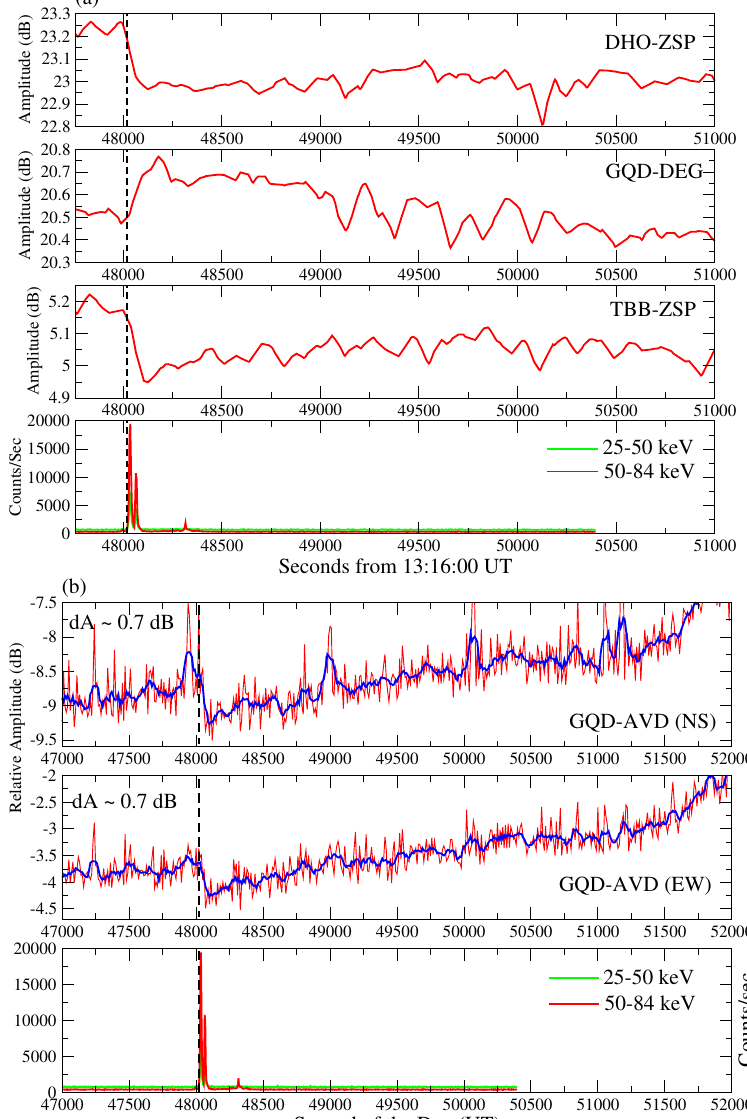
Figure 3. Daytime VLF signal perturbations associated with the GRB220910A in the short propagation paths ( a ) and long propagation paths ( b ). The lowest panel shows the light curves of the GRB in two energy bands 25–50 keV (green) and 50–84 keV (red). The vertical dashed line indicates the event trigger time. For the zoomed version of the GRB burst, please see the lowest panel of Figure